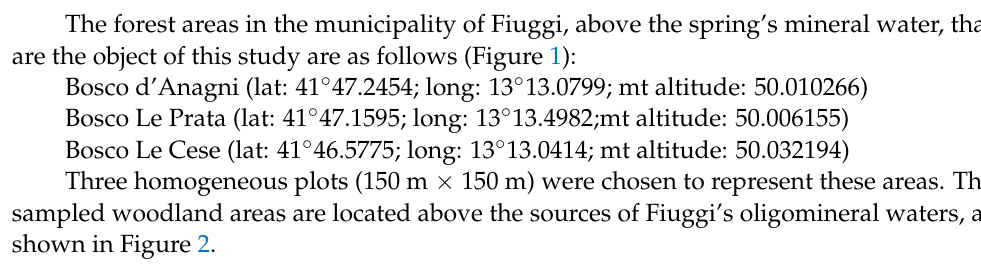
Figure 1. Geographical location of the area of study.